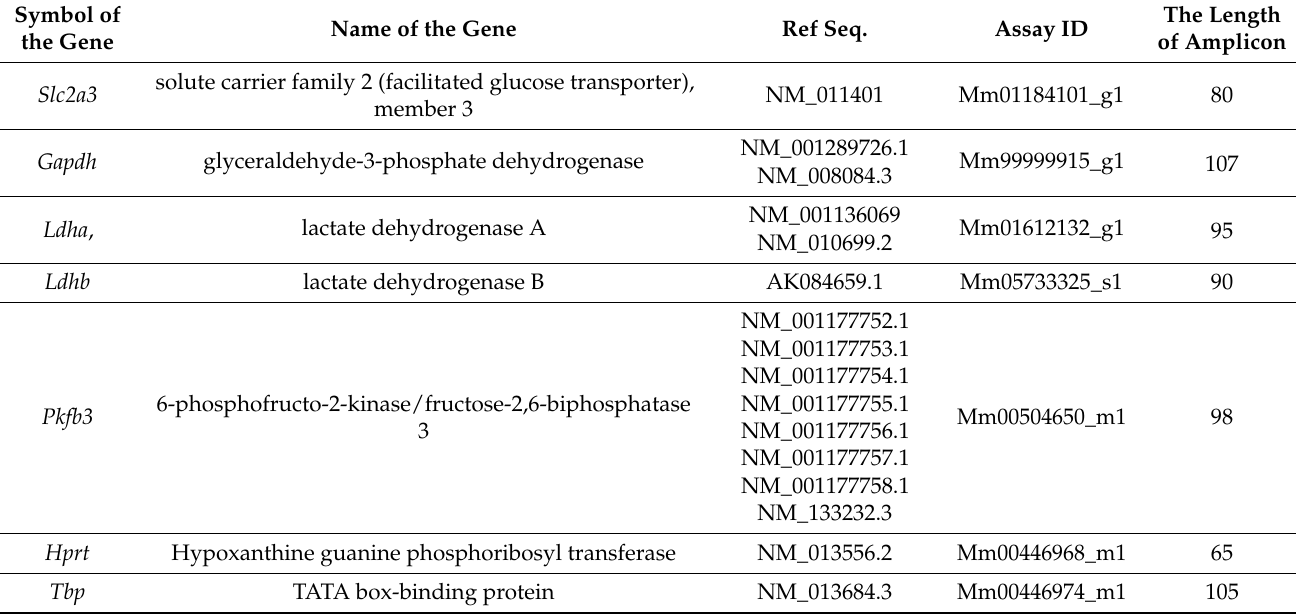
Table 1. The symbols and names of the genes, GenBank reference sequence accession numbers, assay IDs, and the lengths of amplicon (bp).